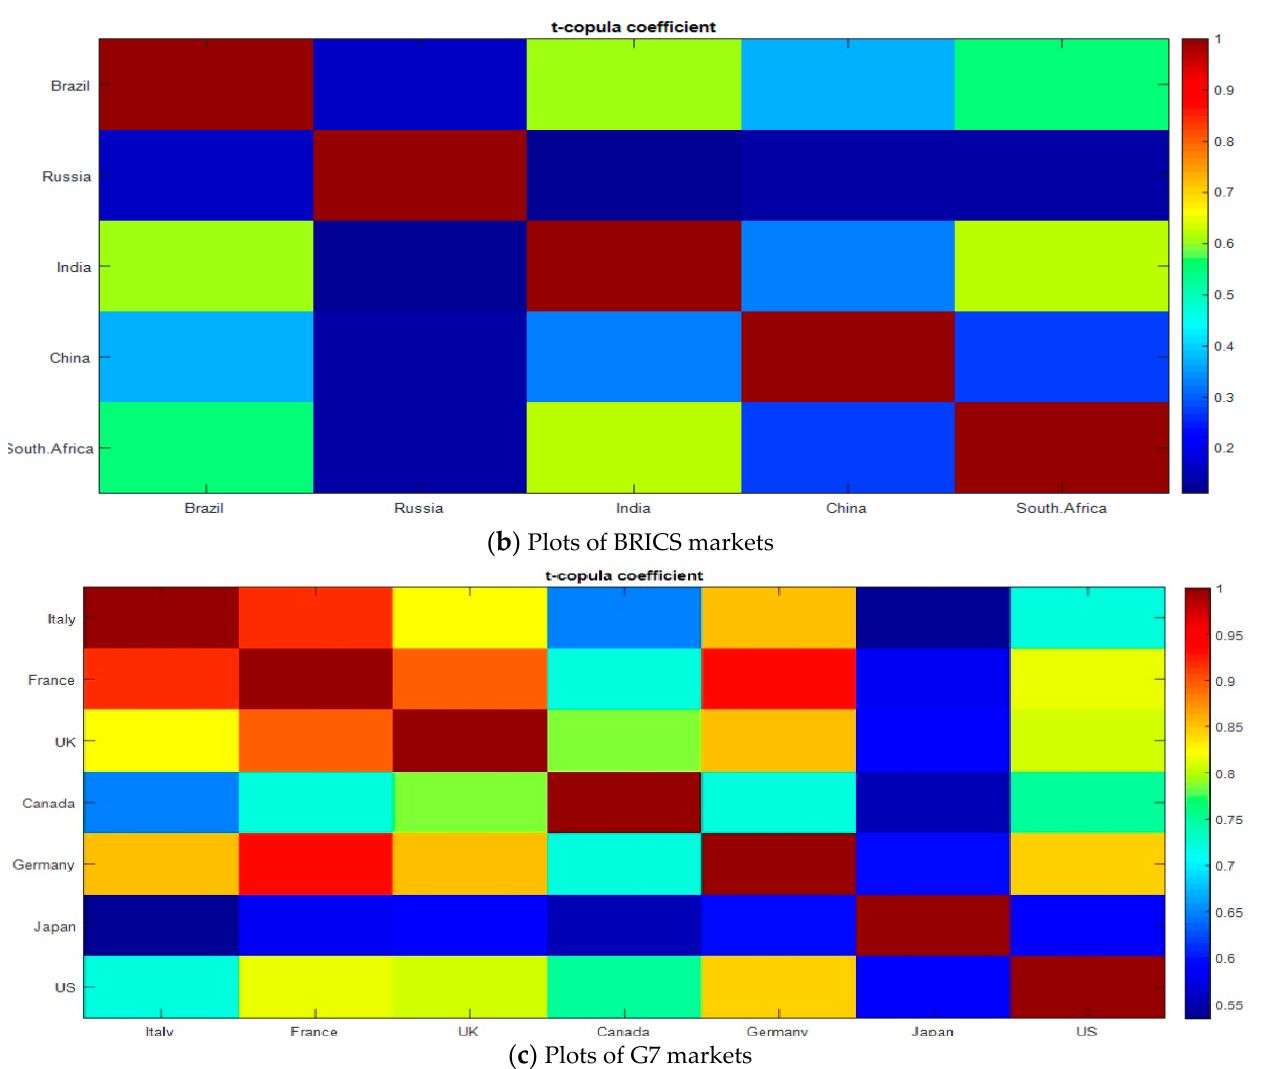
Figure 3. Elliptical copula coefficients.